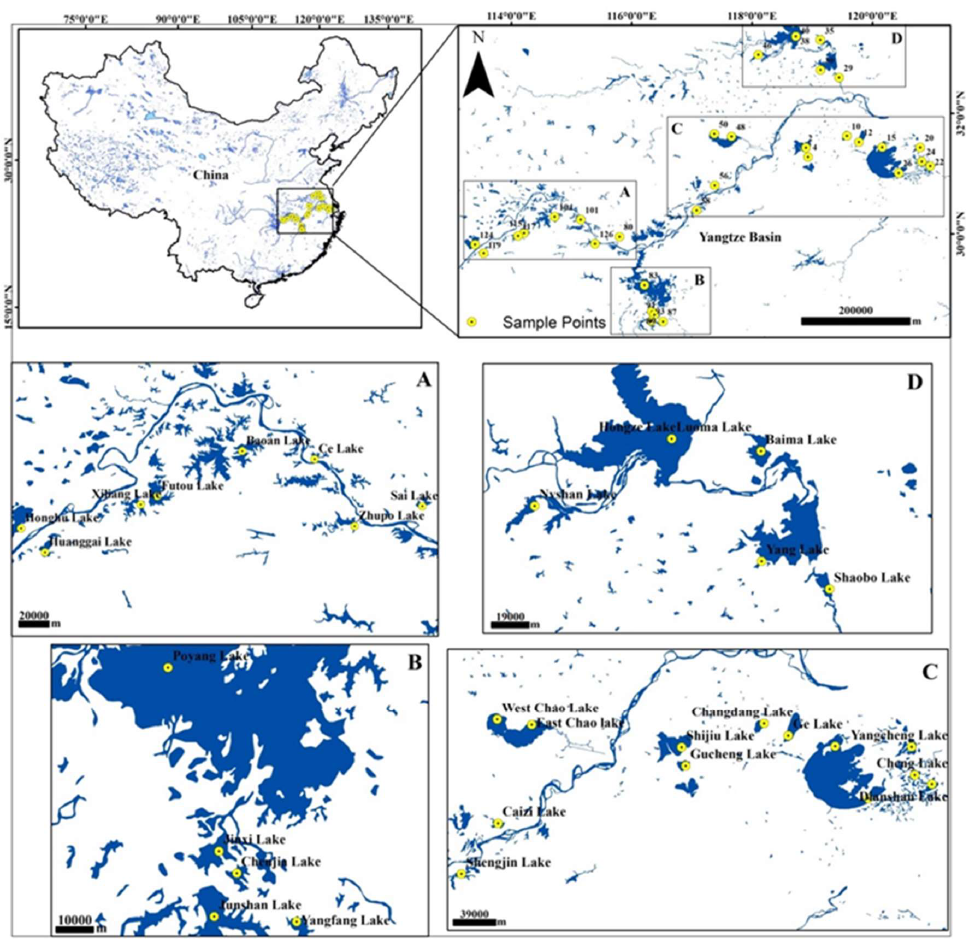
Figure 1. Location of study sites in middle and lower reaches of the Yangtze River system (China) in anti-clockwise order. ( A ) Enlargement of the study sites showing the upper section of the reach; ( B ) Enlargement of the study sites showing the middle section of the river reach; ( C ) Enlargement of the study sites showing the lower section of the river reach; ( D ) Enlargement of the study sites showing the sites around the Honge Lake complex. The largest lake among the study sites, the Poyang Lake, is at the middle section, while the other large lake, Taihu Lake, is at the lower section of river.